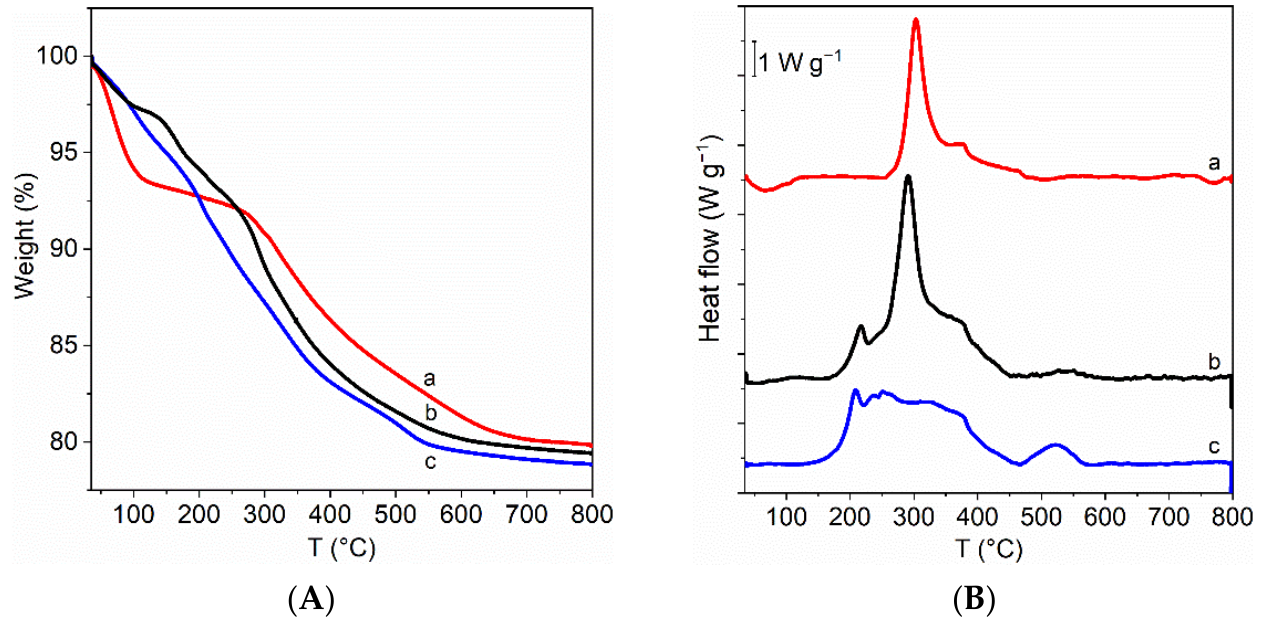
Figure 5. ( A ) Thermogravimetric (TG) analysis, as sample weight (%) versus temperature, ( B ) differential thermal analysis (DTA) as heat flow (W g − 1 ) versus temperature patterns of samples: (a) NH 2 -SiO 2 , (b) Pd 0 /NH 2 -SiO 2 , (c) Pd-P/NH 2 -SiO 2 . TG profiles of Pd 0 /NH 2 -SiO 2 and Pd-P/NH 2 -SiO 2 catalysts show a similar progressive